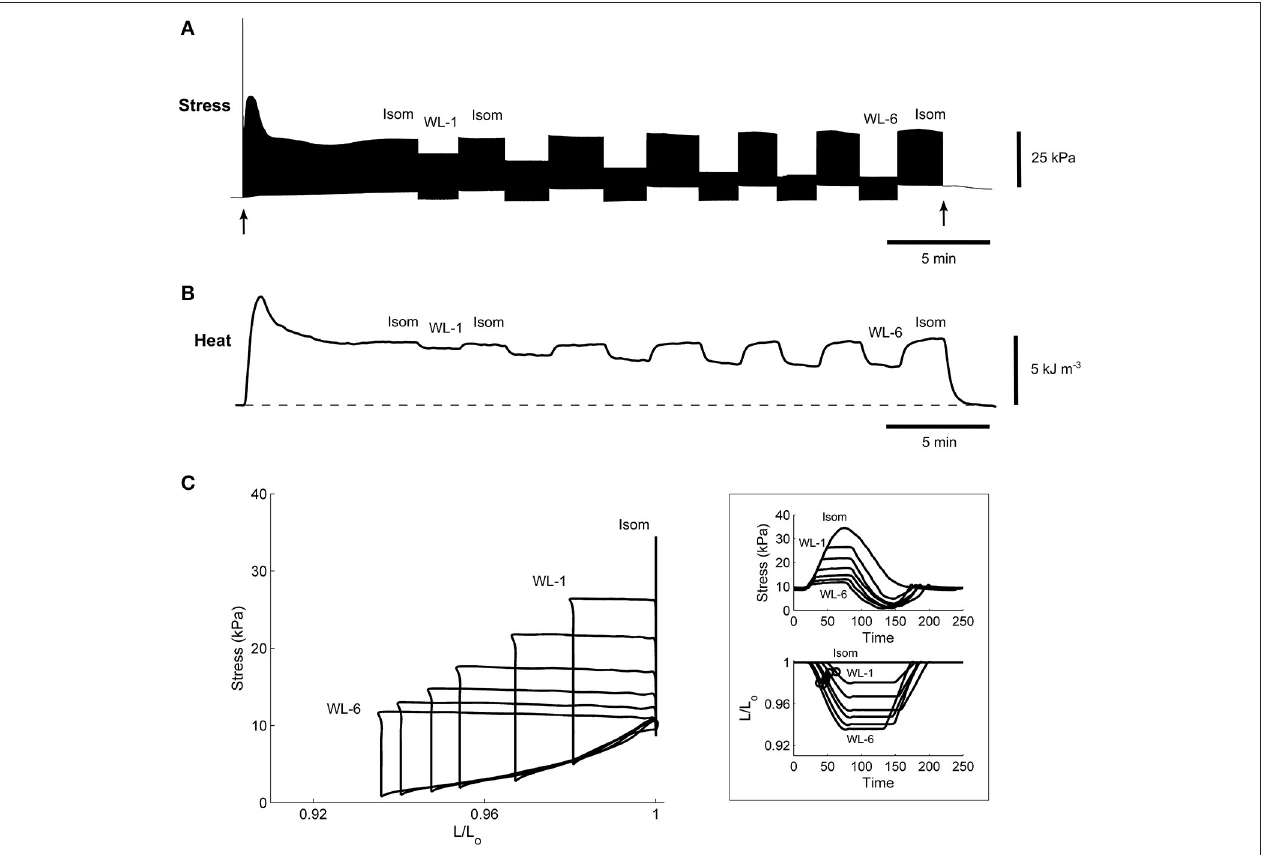
FIGURE 6 | A representative experimental record of a single trabecula undergoing work-loop contractions . Stimulation started at the time indicated by the first arrow and halted at the second arrow. The trabecula underwent a series of work-loop contractions at 6 different afterloads (labeled “WL-1” and “WL-6”) until steady-state ( ∼ 2min) before and after an isometric contraction (labeled “Isom”), where its stress production (A) , suprabasal heat output (B) , and length change (not shown) were simultaneously recorded. Steady-state work-loops resulted from plotting stress as a function of length (C) . The inset in (C) shows the steady-state twitch-time profiles (upper panel) and corresponding length changes (lower panel), where the open circles indicate the maximal slopes during the shortening phase and are an index of velocity of